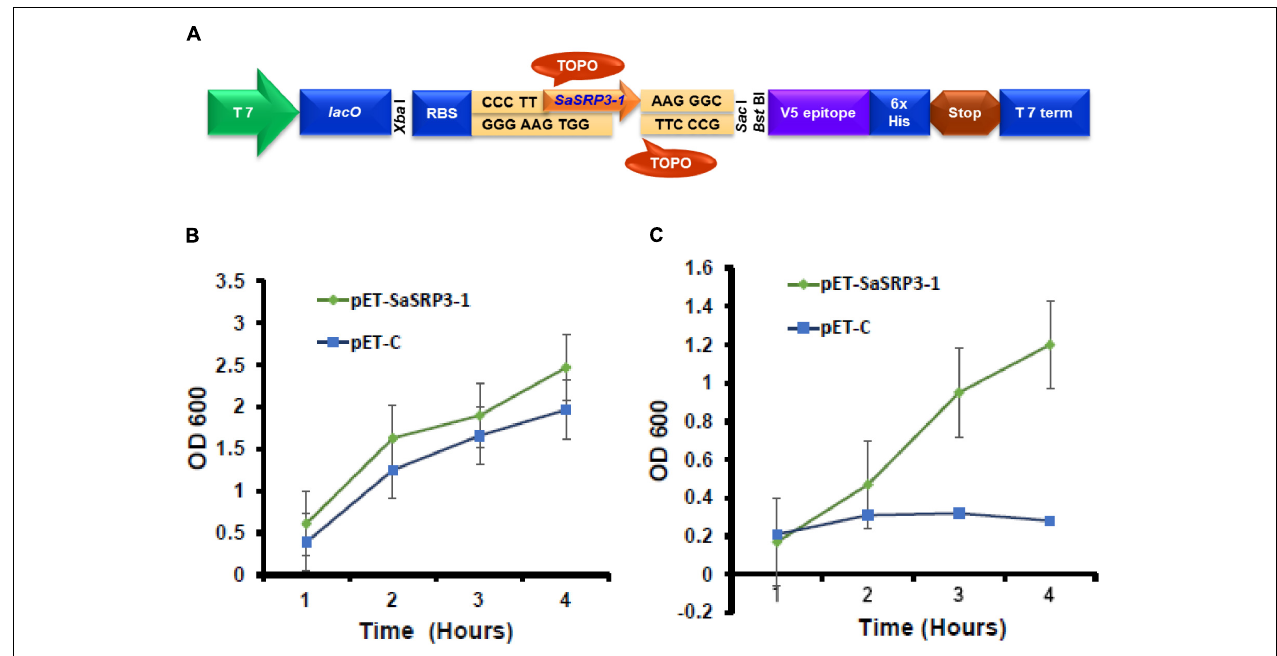
FIGURE 1 | Cloning of SaSRP3-1 into E. coli expression vector pET101/D-TOPO R (cid:13) . (A) Schematic representation of pET101/D-TOPO vector with cloning site, (B) Differences in the growth response curve of E. coli cells grown in the absence of NaCl in liquid LB culture. (C) Growth of E. coli cells after adding 600 mM NaCl to liquid LB media SaSRP3-1: pET-SaSRP3-1, ExCt1: pET-C. The mean of three independent measurements (OD 600 ) are indicated at different time